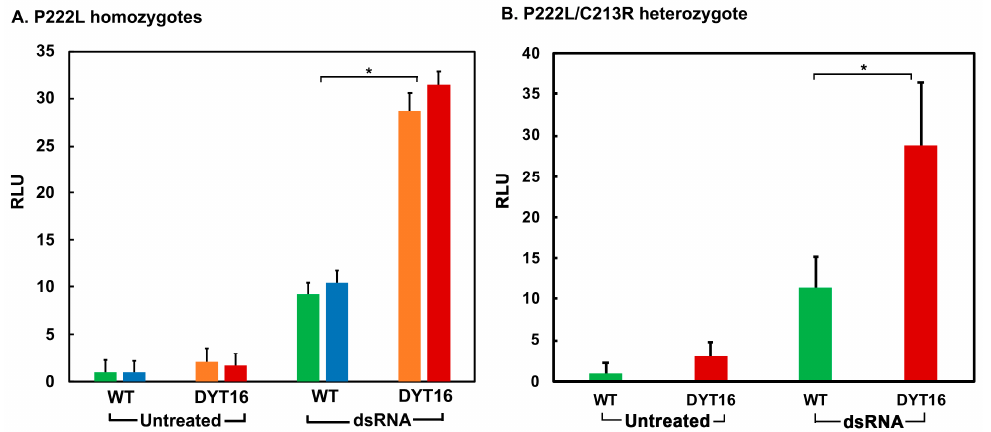
Figure 4. Enhanced induction of IFN β in DYT- PRKRA patient lymphoblasts in response to dsRNA. DYT- PRKRA and normal lymphoblasts were transfected with IFN- β -Luc reporter and pRLnull plasmids, then transfected with LMW polyI:C at 24 h after the plasmid transfections. Cell extracts were assayed for dual luciferase activity 16 h after polyI:C treatment. ( A ) IFN β induction in P222L homozygous lymphoblasts. Green and blue bars: lymphoblasts from two unaffected (wt) individuals. Orange and red bars: lymphoblasts from two unrelated DYT- PRKRA individuals. *: The p -values (indicated by asterisk) based on 3 independent experiments with each sample in triplicates were significant and <0.001. ( B ) IFN β induction in P222L/C213R compound heterozygous lymphoblasts. Green bars: lymphoblasts from one unaffected family member. Red bars: lymphoblasts from an DYT- PRKRA individual. The p -values (indicated by asterisk) based on 3 independent experiments with each sample in triplicates were significant and